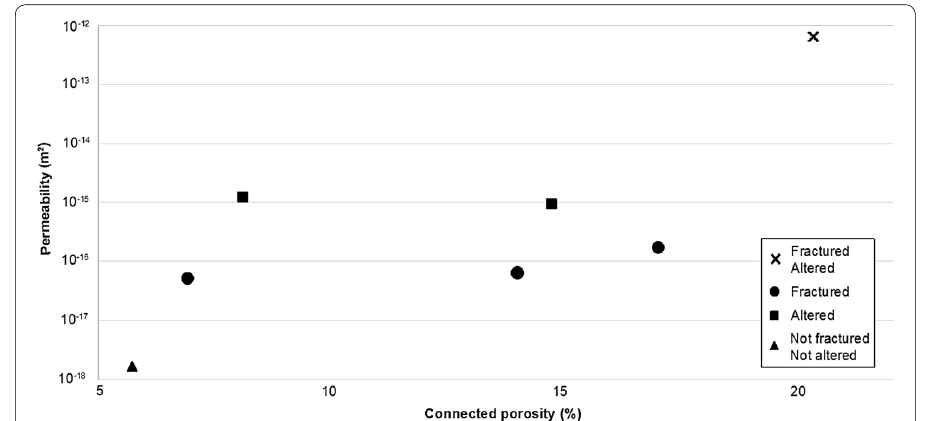
Fig. 10 Connected porosity and permeability measurements on sample taken from the Peyrouse 1 borehole (identical to those used for qualitative observations). The non‑fractured and unaltered samples have the lowest permeability and connected porosity value. Conversely, the altered and fractured sample has the highest value of permeability and connected porosity. These purely qualitative degrees of alteration and fracturation are based on macroscopic, microscopic observations and three‑dimensional visualization